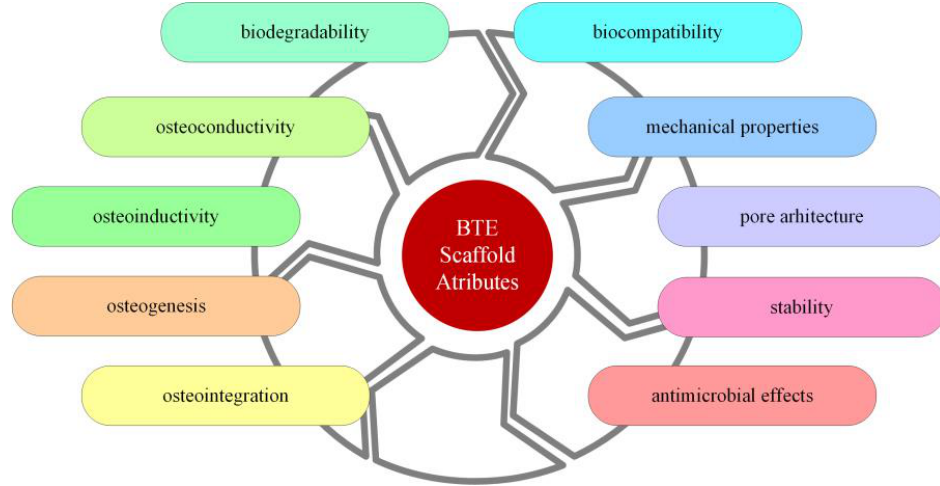
Figure 1. The most important attributes of a